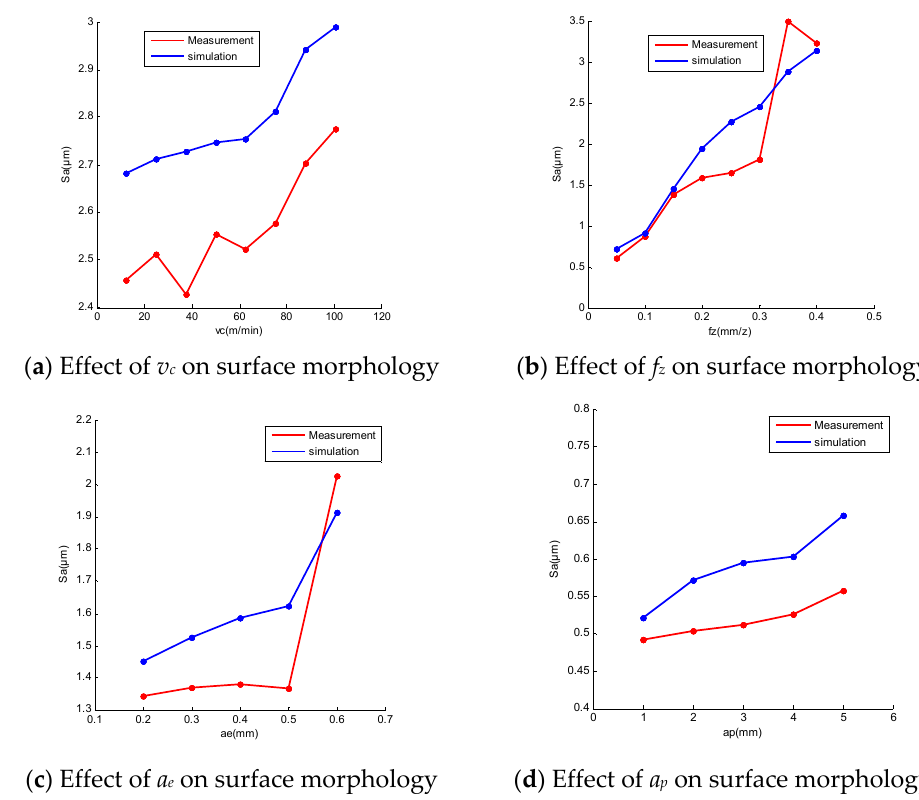
Figure 13. Effect of milling parameters on surface topography.